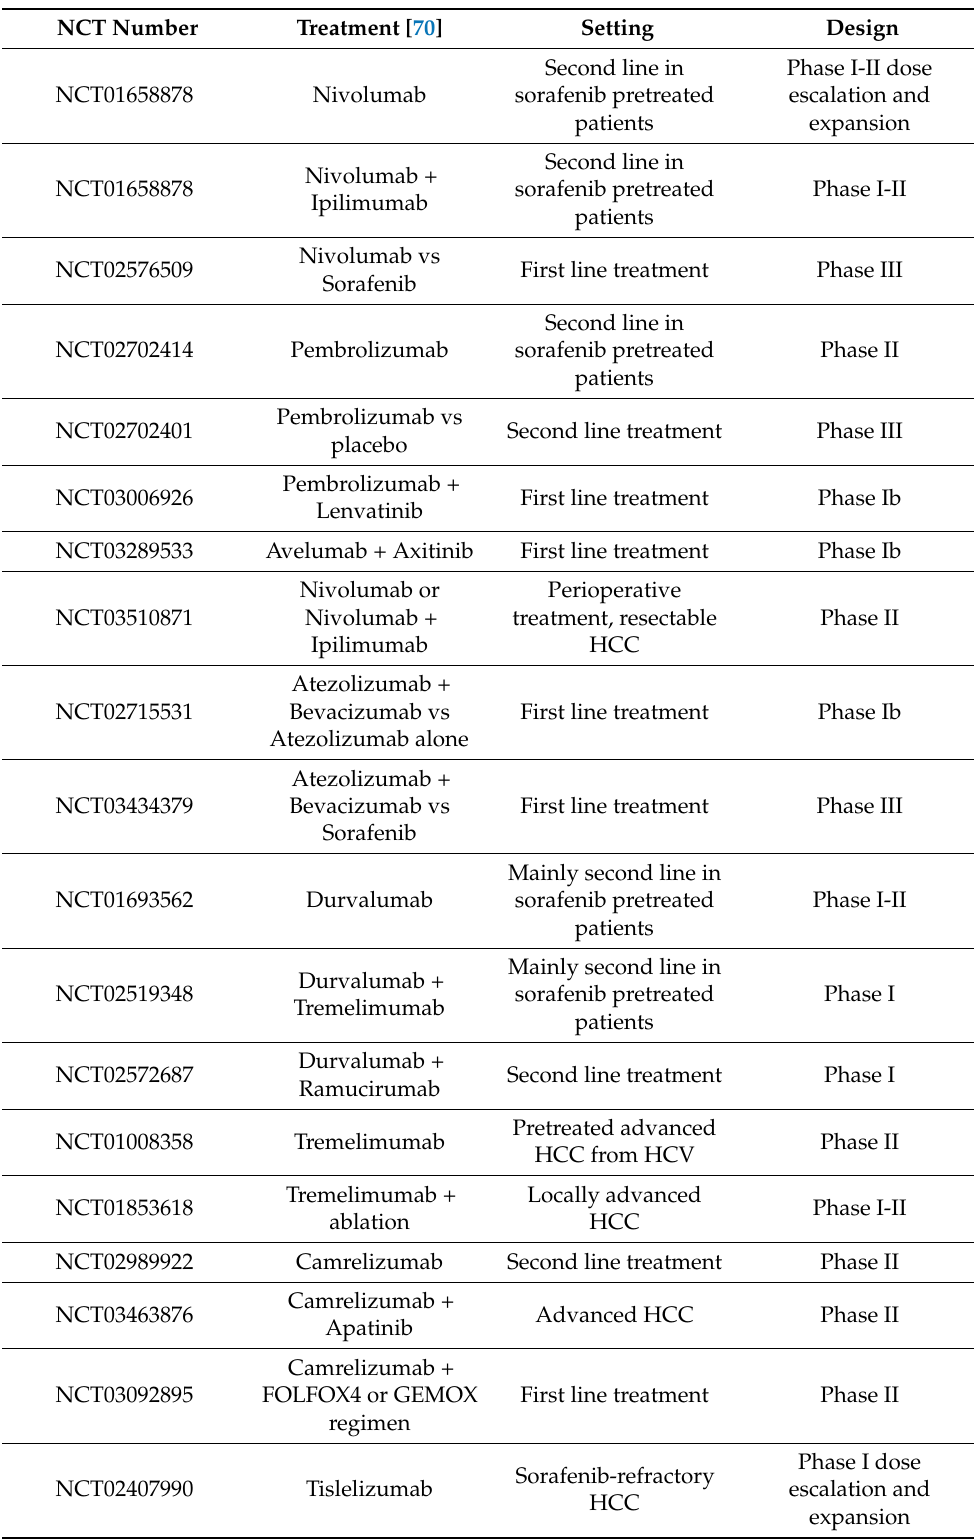
Table 1. Summary of clinical trials involving ICIs for the treatment of